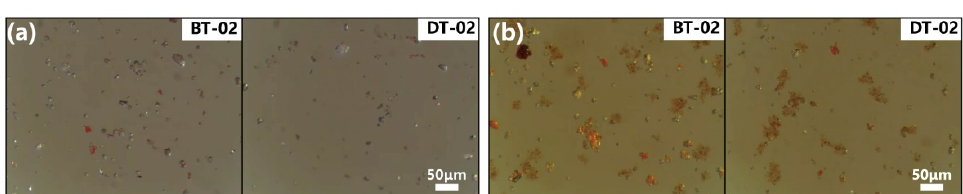
Figure 11. Raman spectra obtained for ground layer materials.